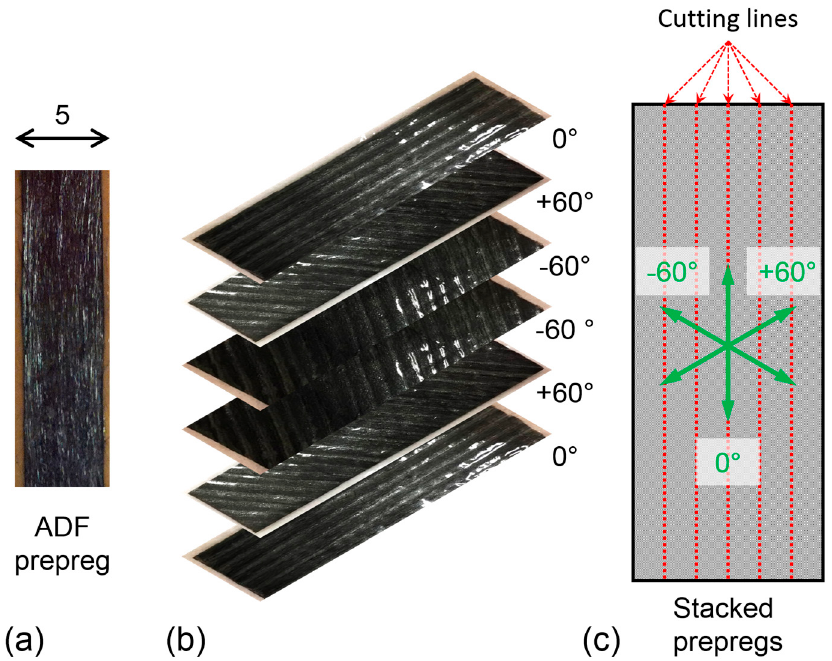
Figure 2. Images showing QI Specimen preparation: ( a ) Aligned discontinuous fibres prepreg tape, ( b ) lay-up and stacking sequence of ADFRC tapes, ( c ) Specimen cutting lines on uncured ADFRC stacked tapes.